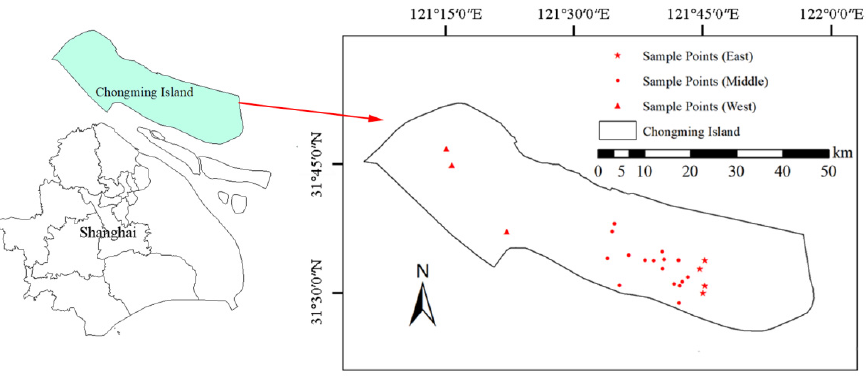
Figure 1. The study area and the distribution of sampling points.